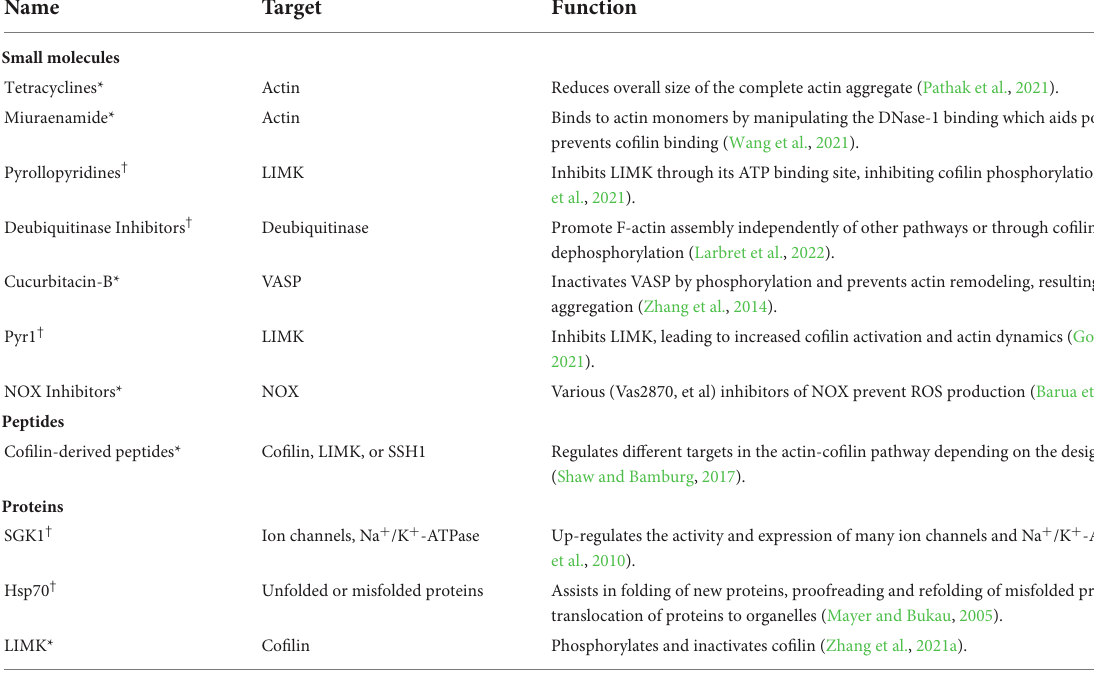
TABLE 1 Proteins, peptides, and small molecule inhibitors of cofilin-actin rods.